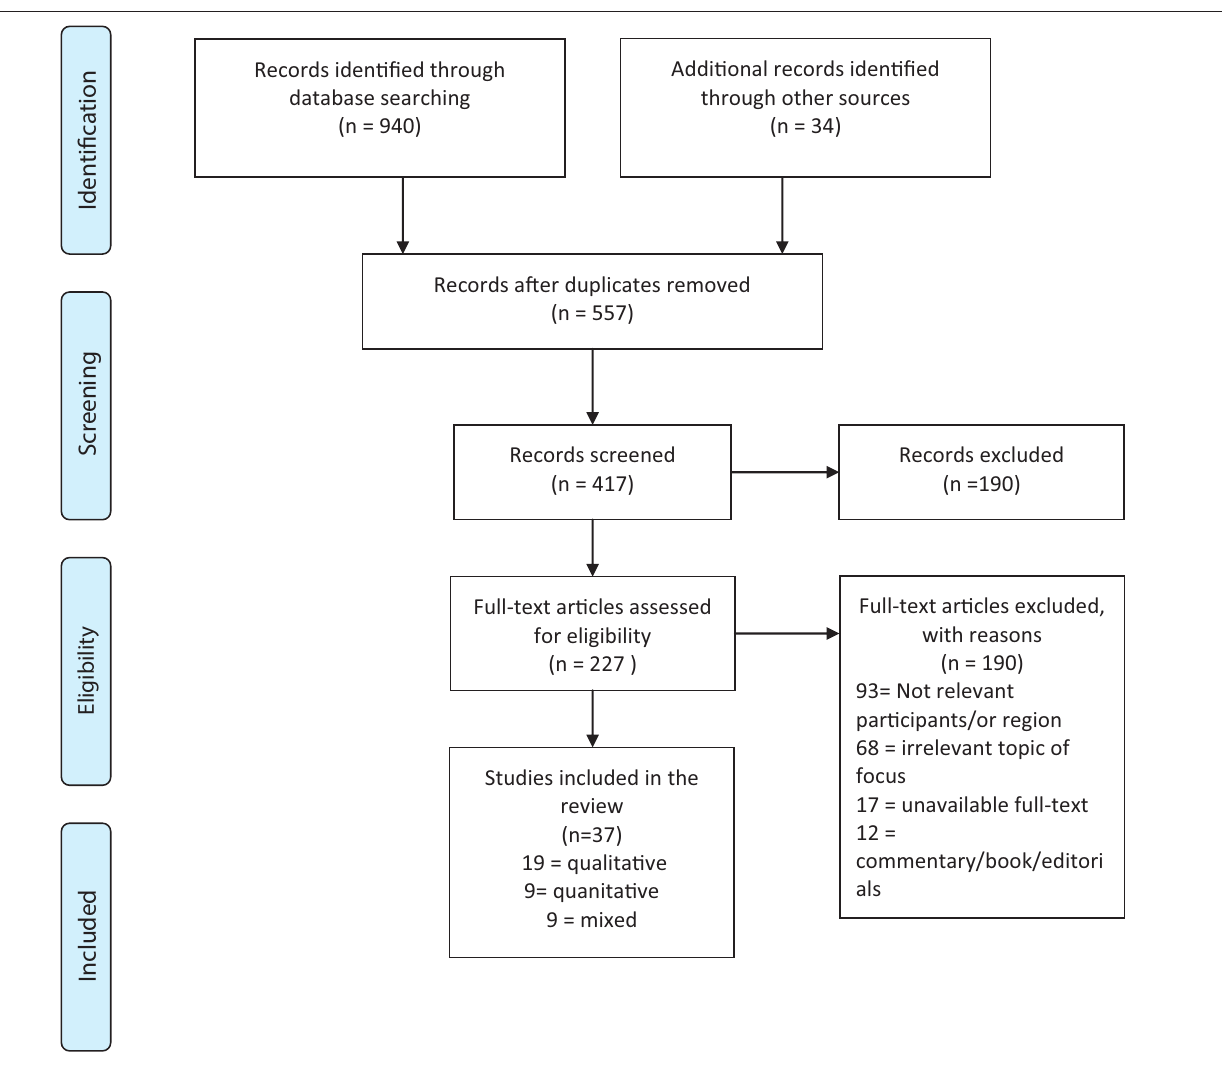
FIGURE 1 | Search, screening, selection, and inclusion process diagram